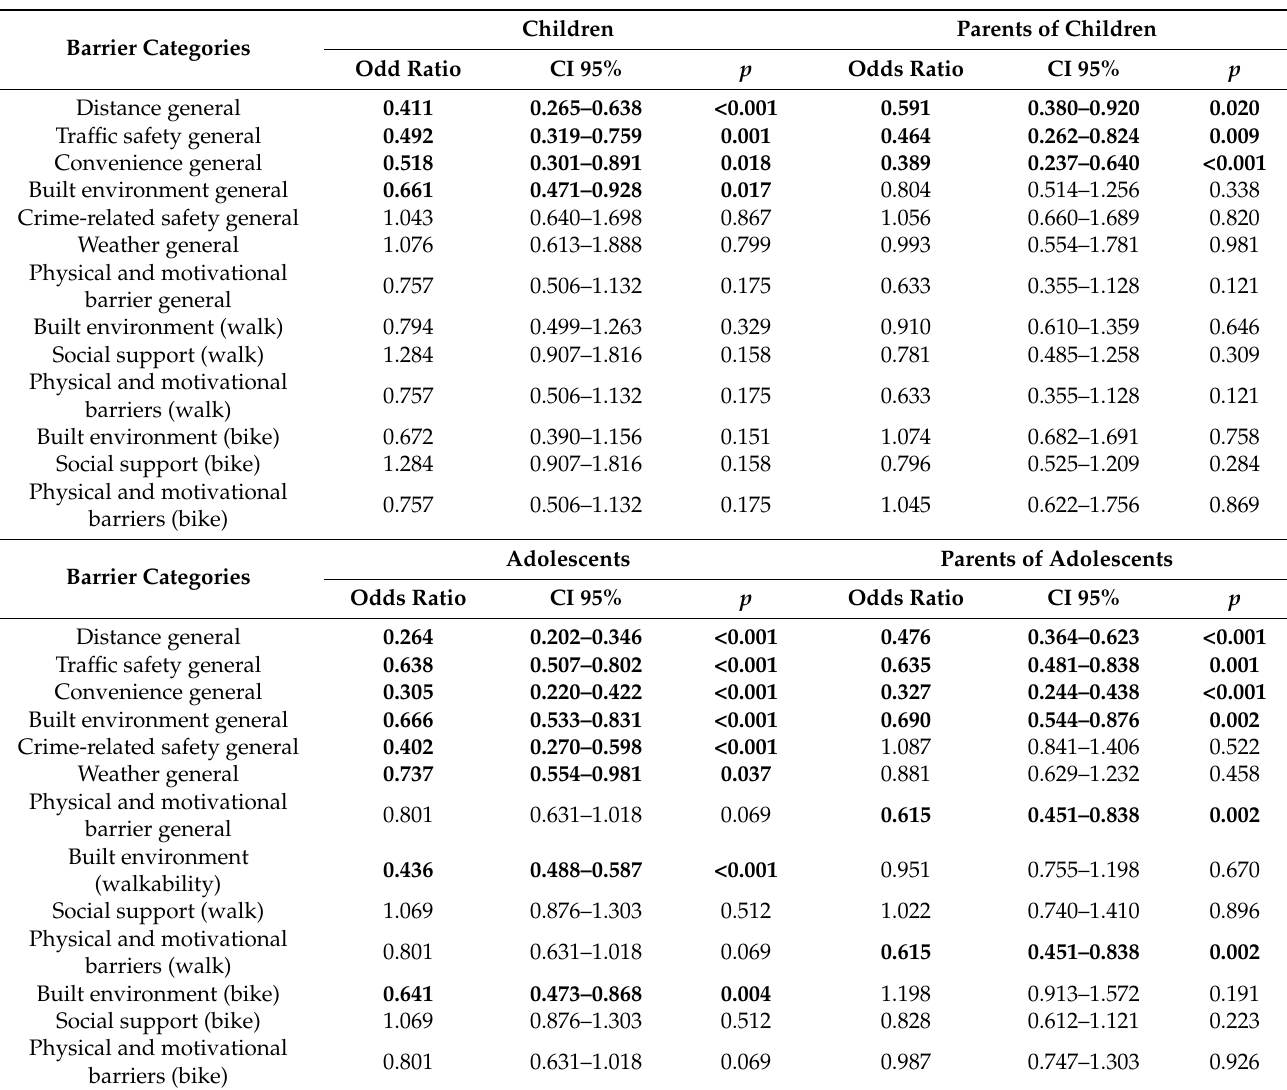
Table 4. Associations between active commuting to and from school (ACS) and the barriers, separated by children and